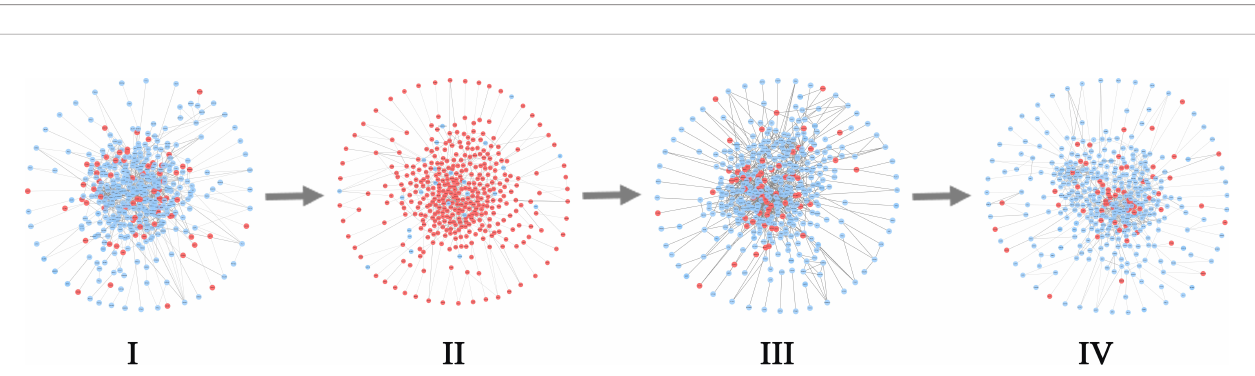
FIGURE 7 | The application of sJSD in three cancers. Identi fi cation of critical transitions in cancer progression: (A) BLCA, (B) CESC, (C) PAAD. The landscapes of global ICI scores for three cancers: (D) BLCA, (E) CESC, (F) PAAD. The landscapes of ICI scores of sJSD signal biomarkers for three cancers: (G) BLCA, (H) CESC, (I) PAAD. Comparison of survival curves for three cancers before and after the critical state: (J) BLCA, (K) CESC, (L)